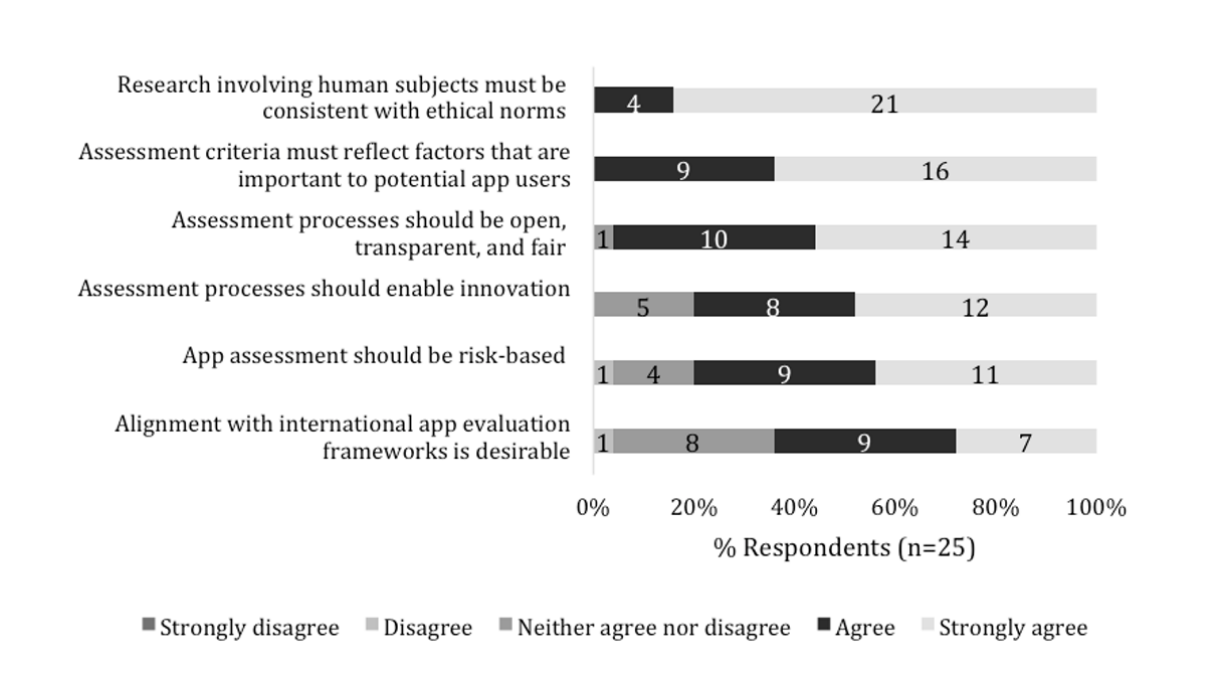
Figure 2. Rating of the initial guiding principles in Round 1.